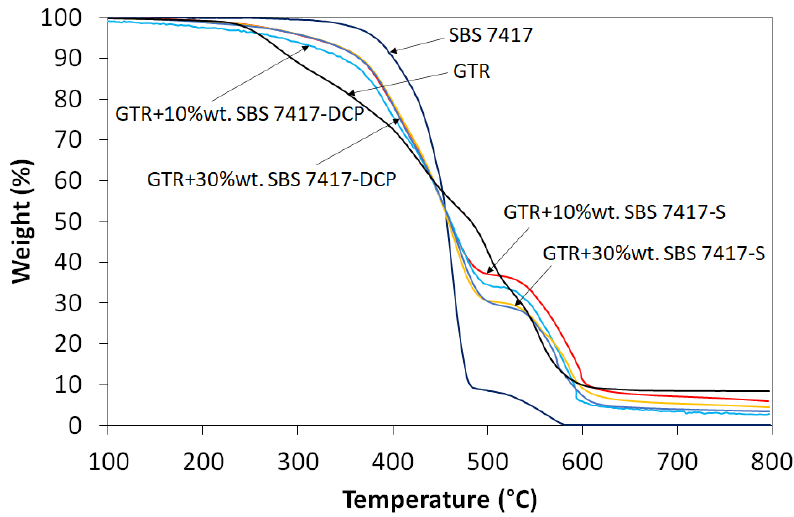
Figure 8. TGA curves for GTR modified by SBS and curing agents .